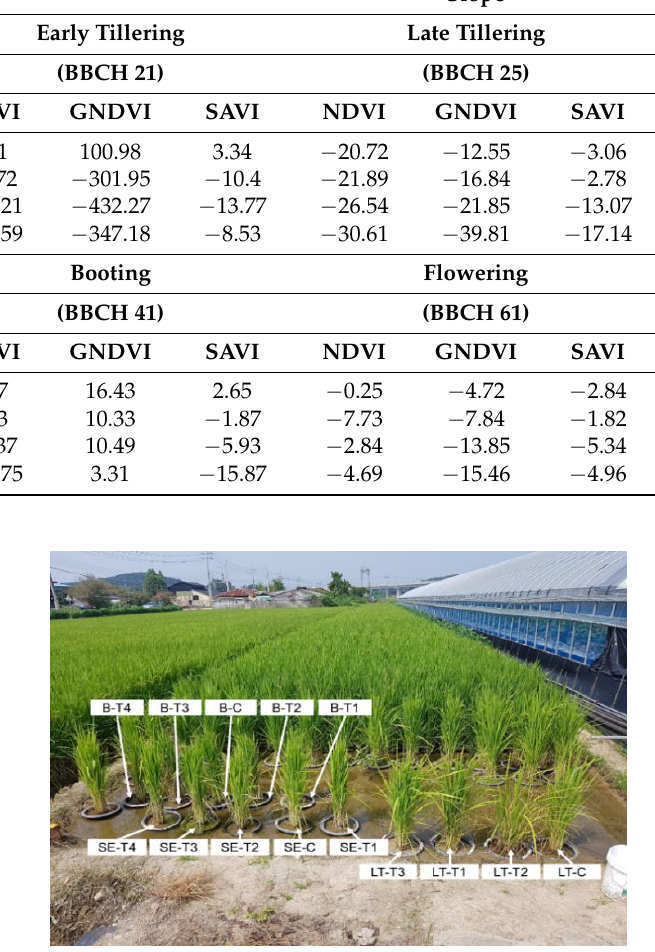
Figure A2. Field plot description for the retransplanted rice. LT, SE, and B indicate the growth stages late tillering, stem elongation, and booting, respectively.